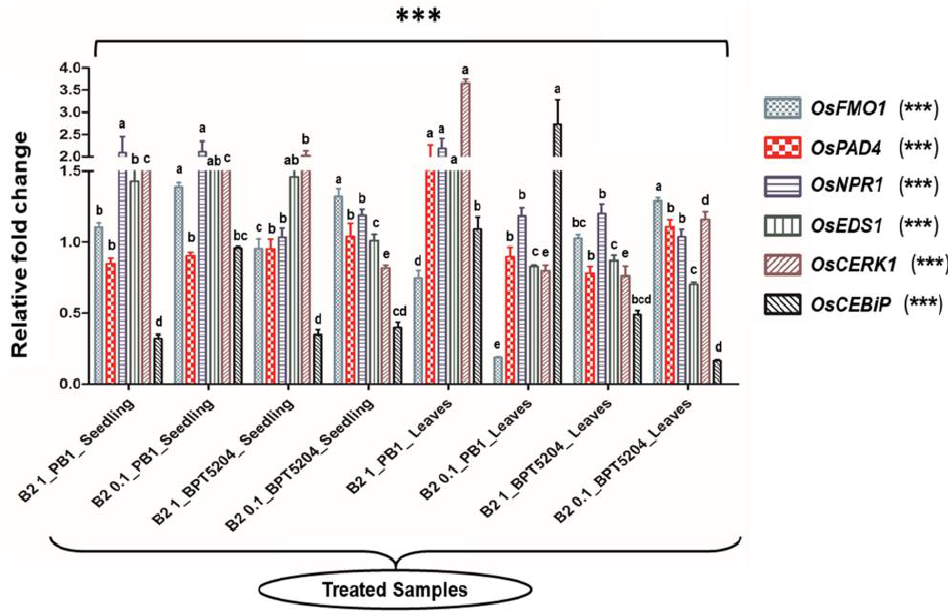
Figure 6. Transcriptional response of defense genes in rice upon bacterization by M. testaceum B2. qPCR-based transcriptional analysis of defense gene expression in rice seedlings upon endobacterization. The fold change values obtained for the defense genes were imported into the GraphPad Prism program (https://www.graphpad.com/scientific-software/prism accessed on 31 October 2022), and two-way ANOVA was conducted using Bonferroni posthoc test for determining the statistical significance at *** p = 0.0001. Refer to Table S10 for data on fold changes in gene expression. (The data designated with different alphabets were significantly different. The letter stands for non-significant.)